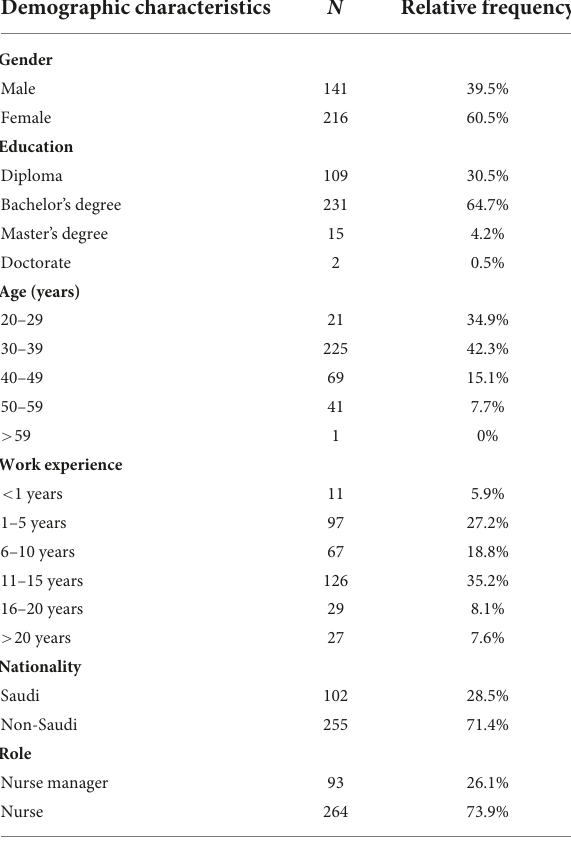
TABLE 1 Participants’ demographic